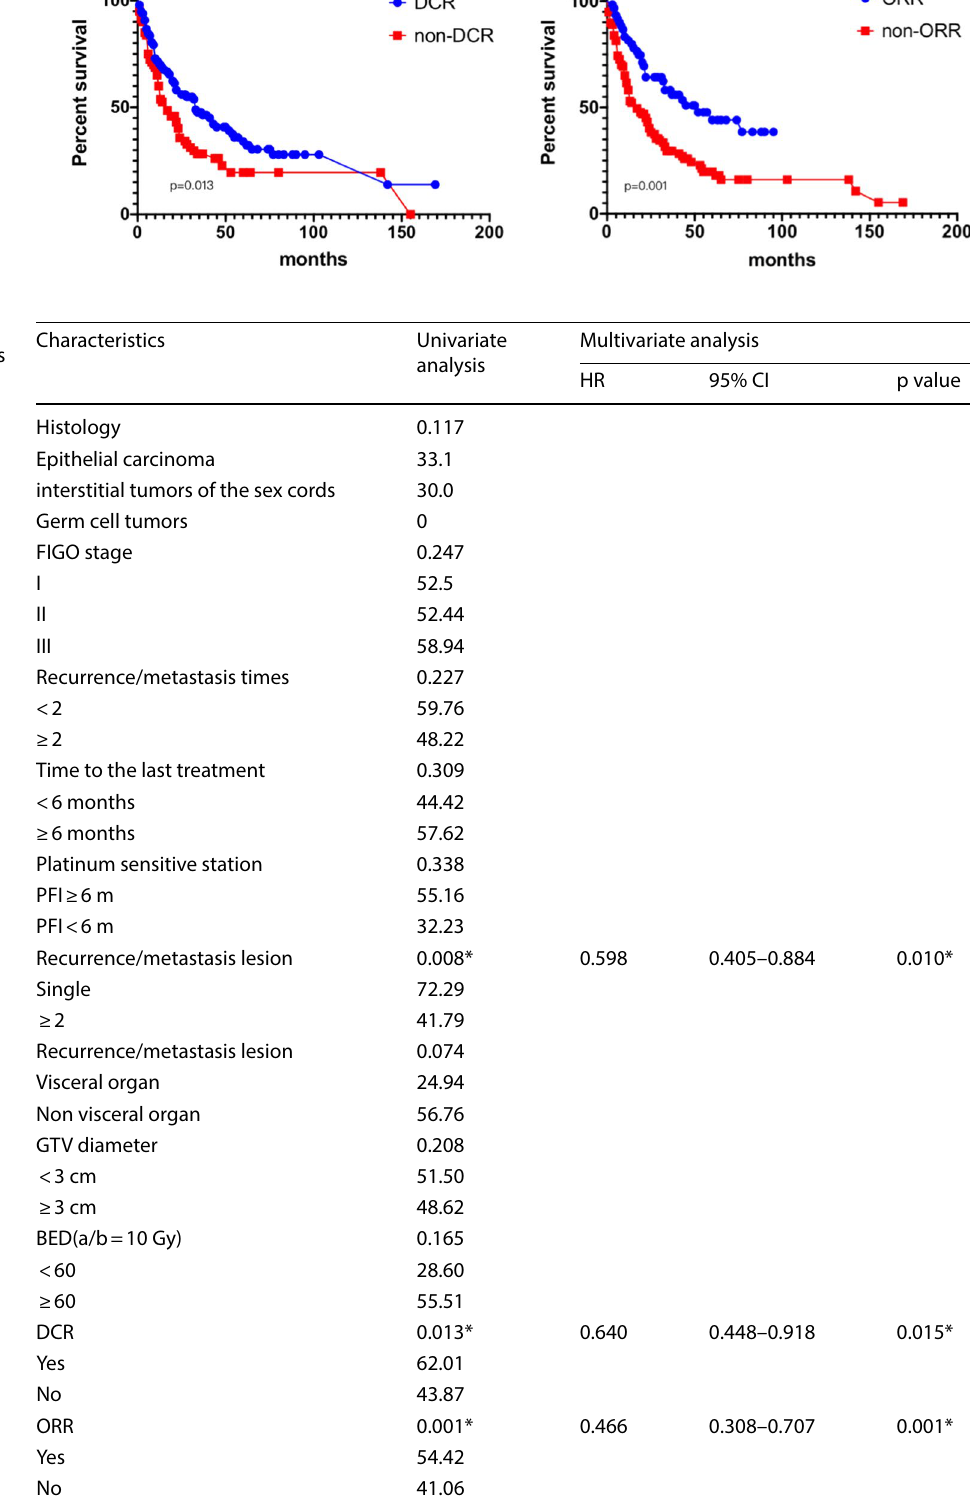
Fig. 6 Overall OS and sub- group analysis (DCR and ORR